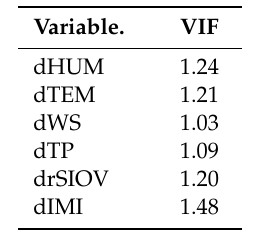
Table 5. Variance inflation factors (VIFs) among independent variables.